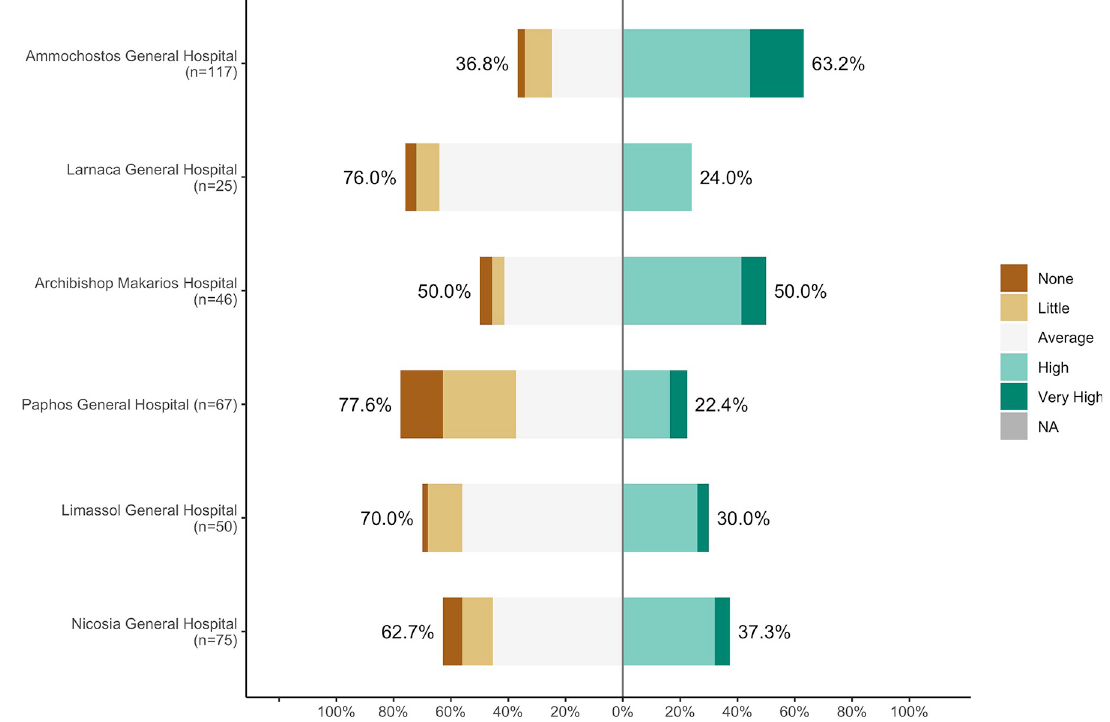
Fig 3. Likert plot showing the extent to which workers of different hospital experience a feeling of safety with the measures taken by their employers.